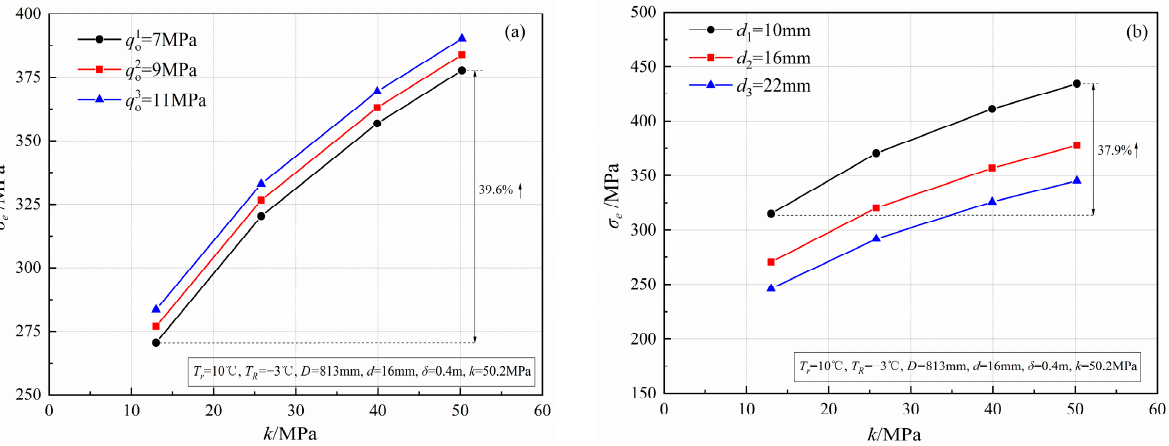
Figure 4. Variations in the equivalent stress with respect to the foundation coefficient. ( a ) Under different oil pressures; ( b ) Under different wall thicknesses.